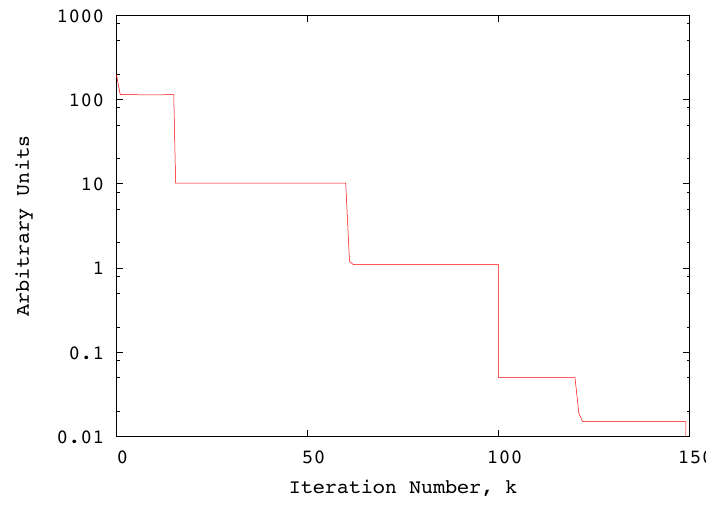
Figure 4. Antenna design, optimization process. Behaviour of the cost function vs. iteration